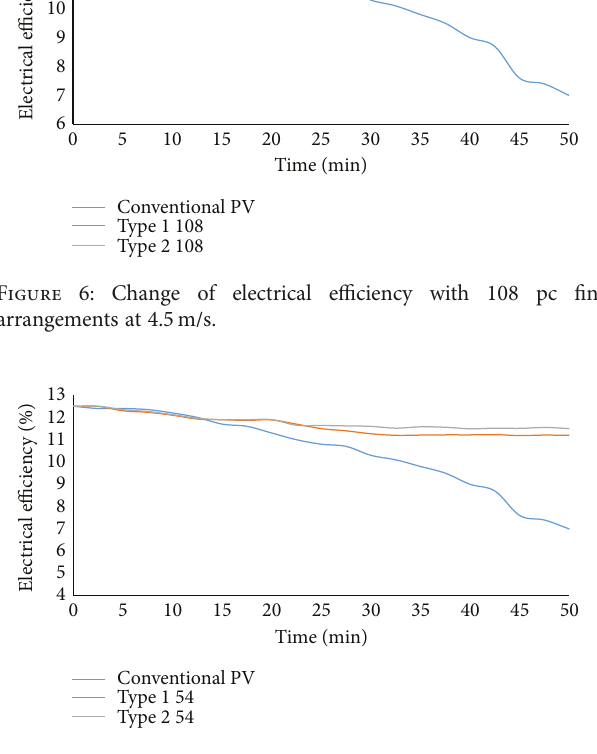
Figure 7: Change of electrical e ffi ciency with 54 pc fi n arrangements at 4.5m/s.